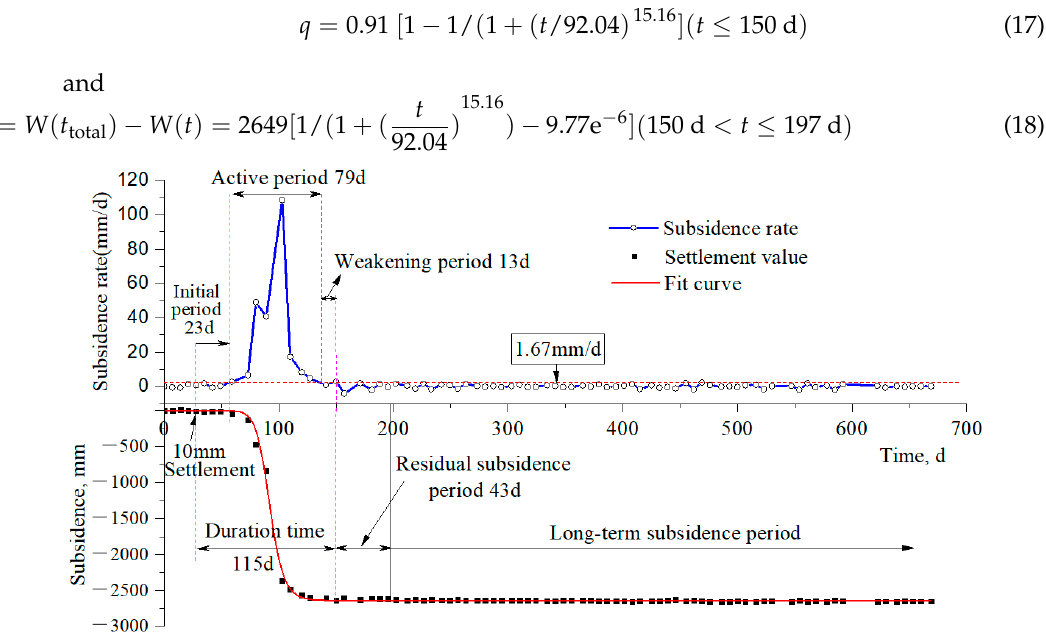
Figure 10. Period values calculated for each temporal sections of surface subsidence over surveying station LX-2-4.